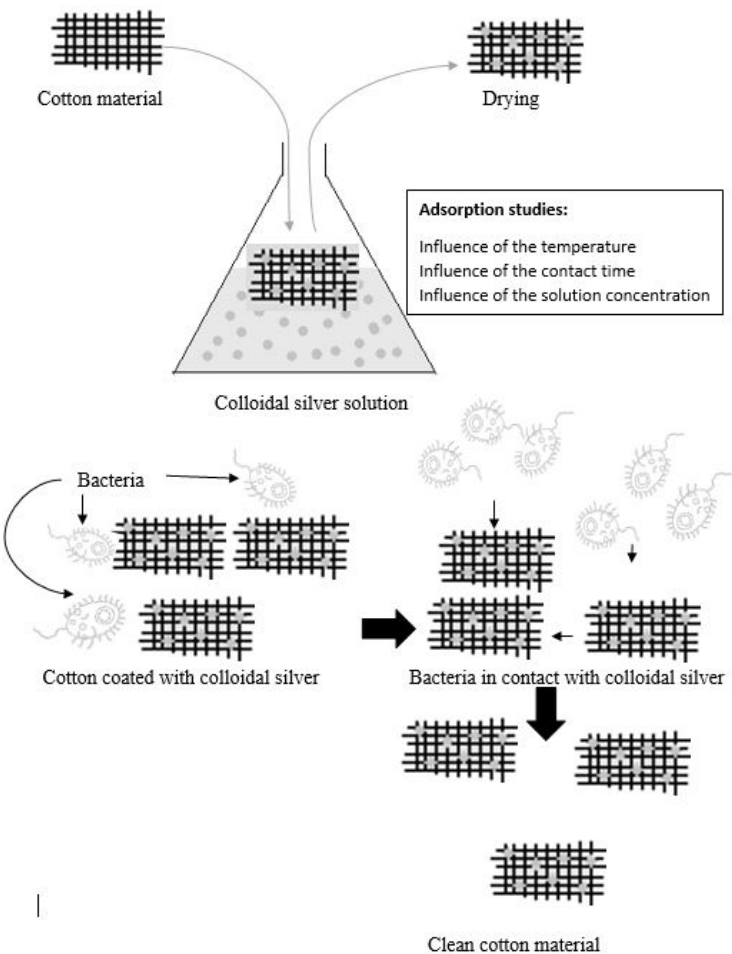
Figure 14. Mechanism of colloidal silver adsorption process.